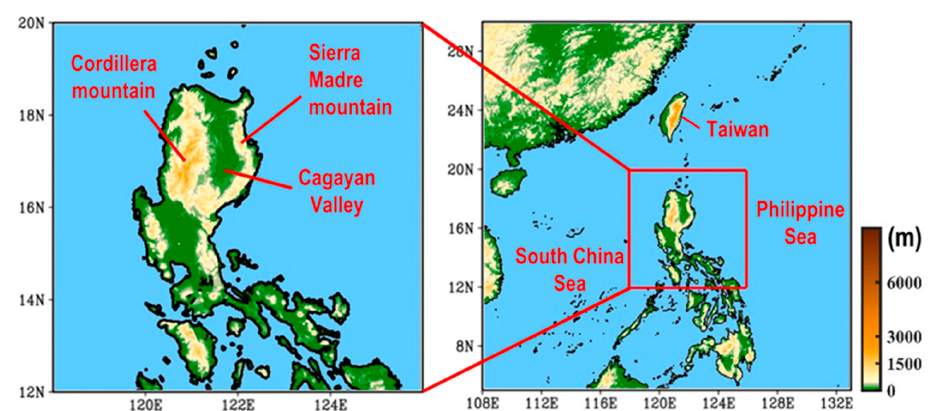
Figure 1. Geographical location and topography of Luzon.